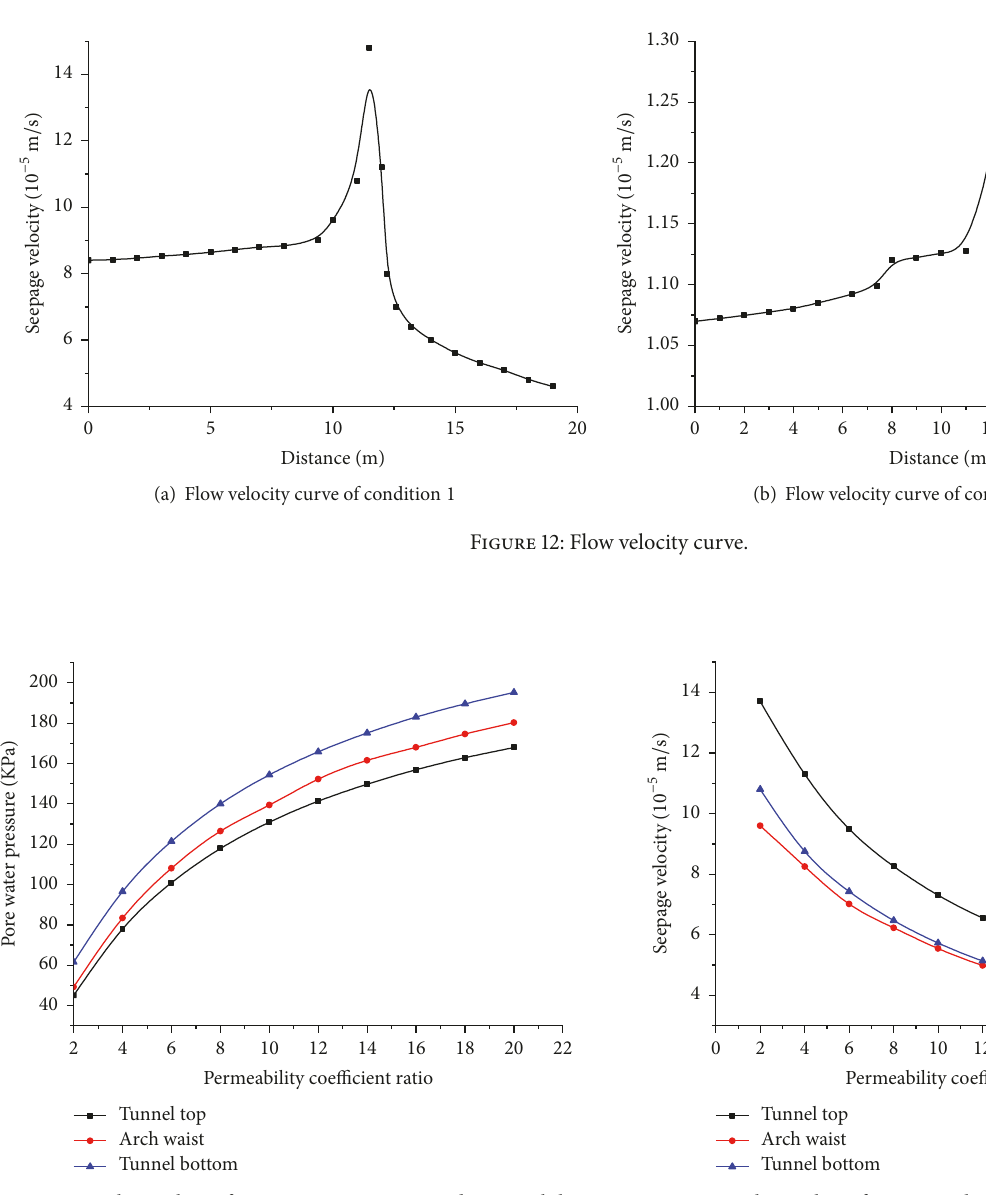
Figure 14: Relationship of seepage velocity and permeability coeffi- cient of grouting circle.